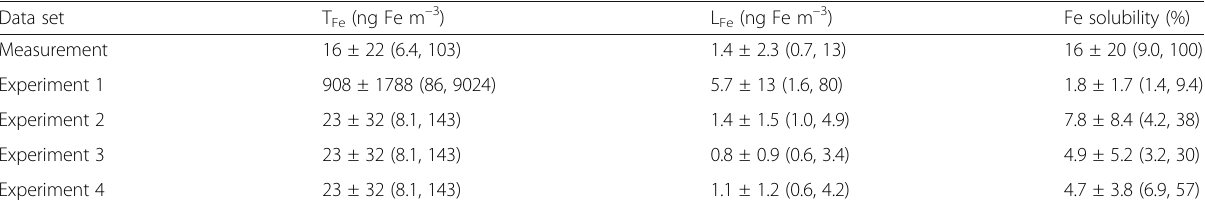
Table 2 Averages and standard deviations of T Fe and L Fe concentrations (ng Fe m – 3 ) and Fe solubility (%) over the 70°E – 150°E and 10°S – 70°S oceanic sector of the SH. The parenthesis represents the median and